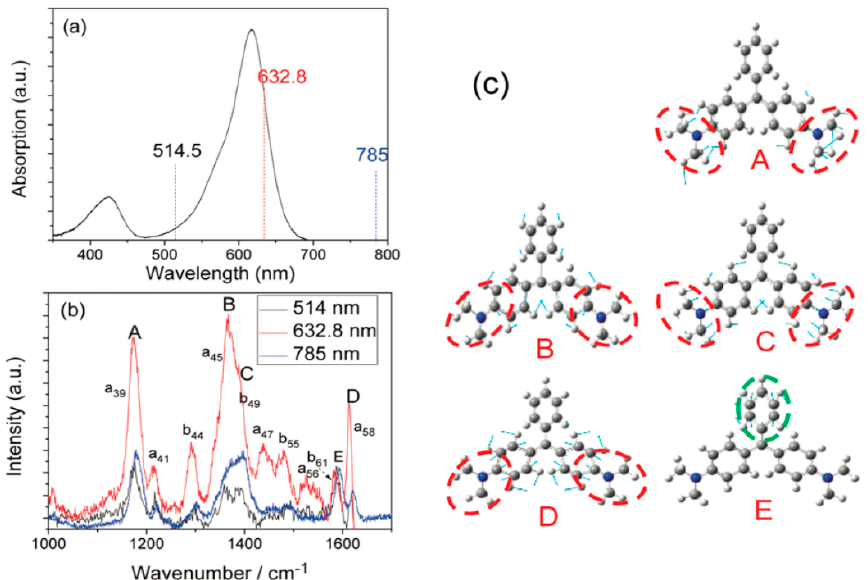
Figure 3. Absorption and Raman spectra and calculated normal modes of MG. ( a ) Absorption spectrum of MG in water, ( b ) surface-enhanced Raman spectroscopy (SERS) and surface-enhanced resonance Raman spectroscopy (SERRS) spectra of MG in Ag sol, and ( c ) vibrational modes A–E of MG. Adapted from [9].